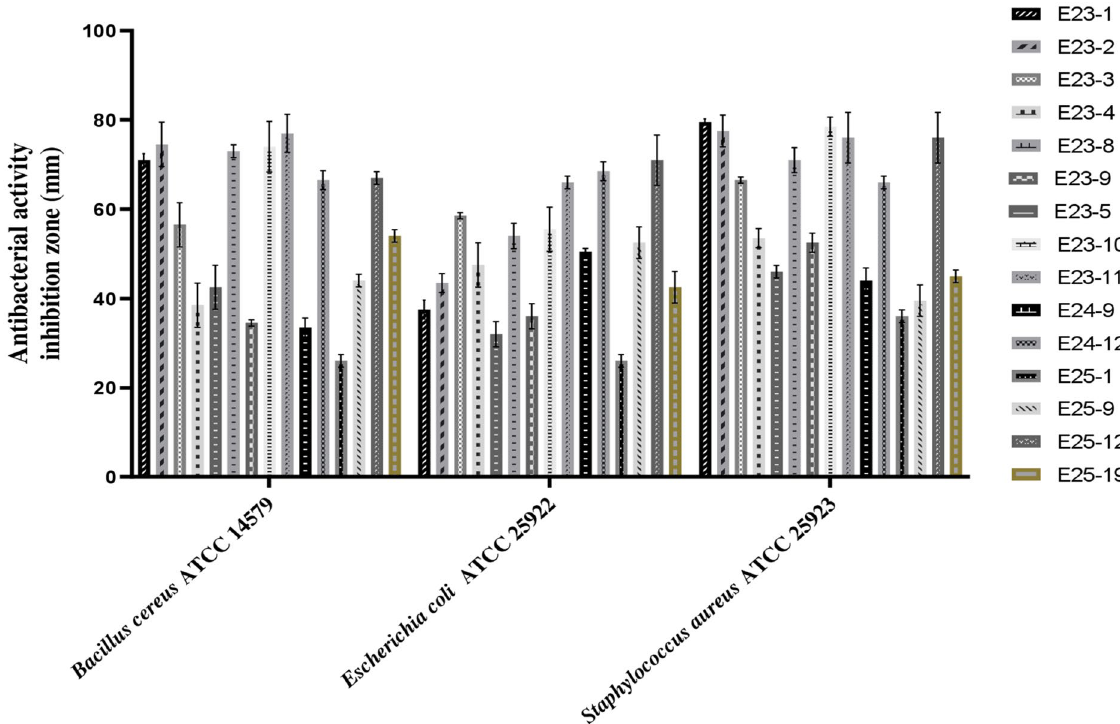
Figure 1. Primary screening (antibacterial activity) using the double layer method on ISP2 medium.